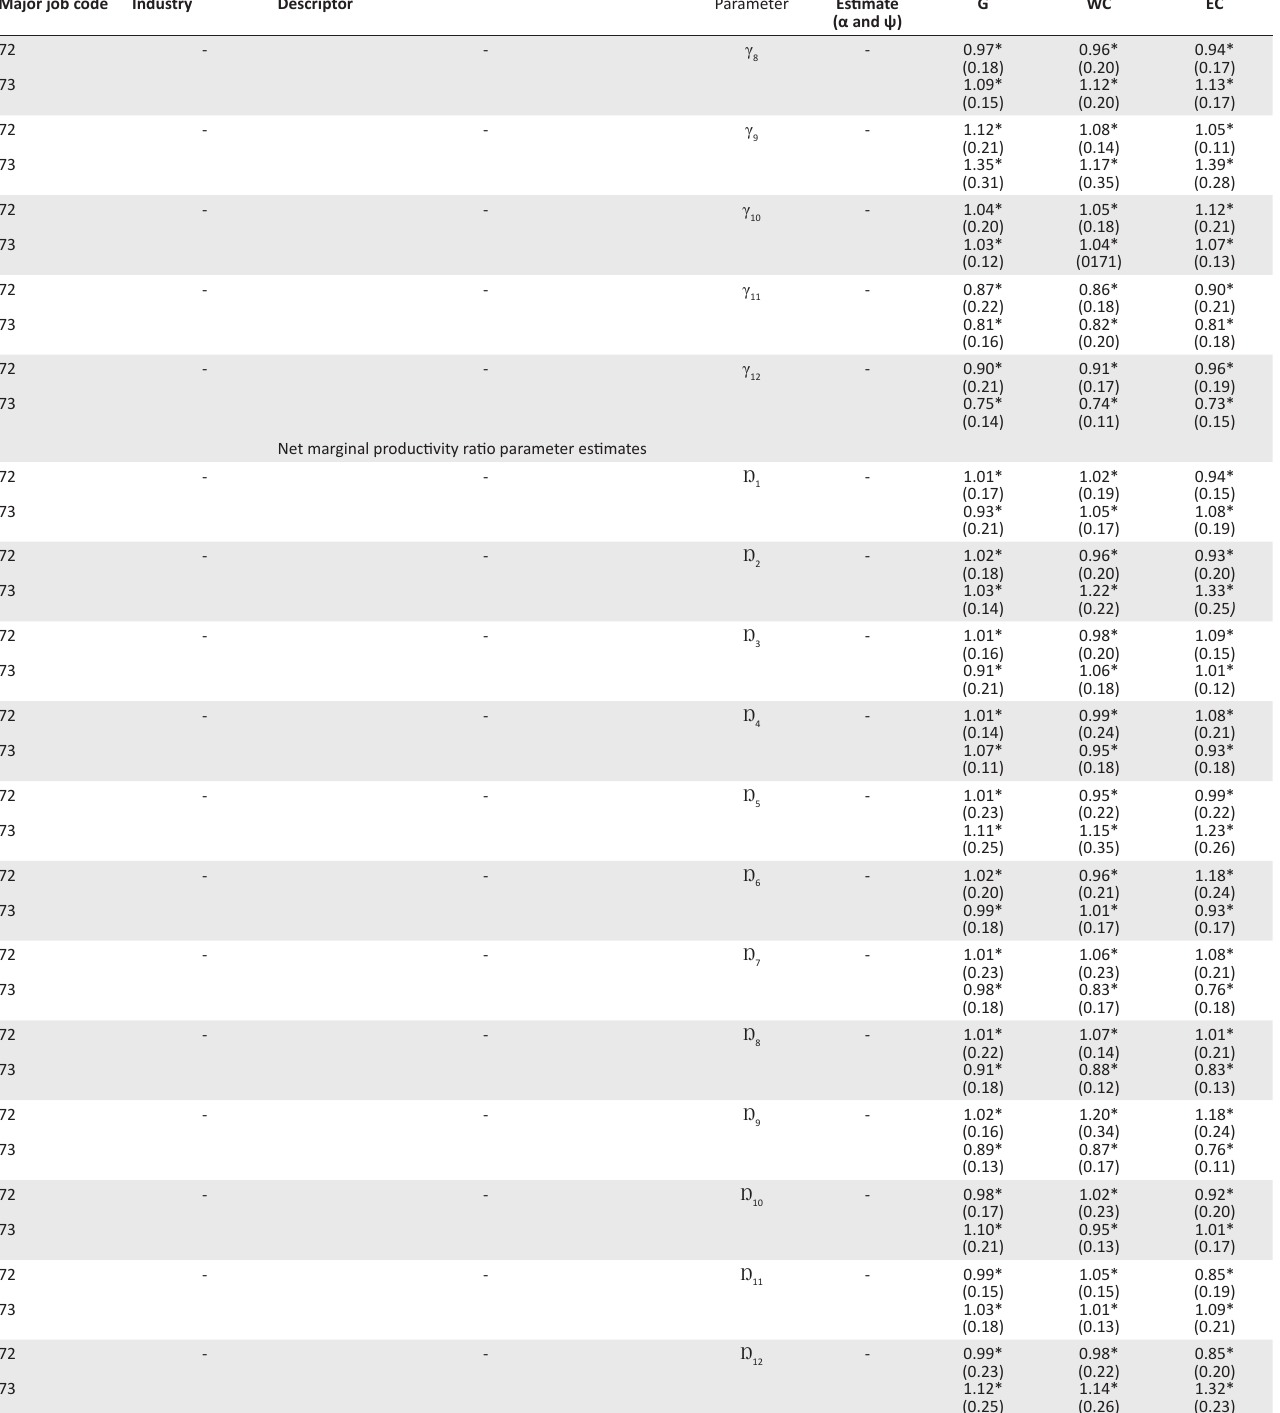
TABLE 4 (Continues...): Capital efficiency, firm-based characteristics and the marginal productivity model estimates for the manufacturing